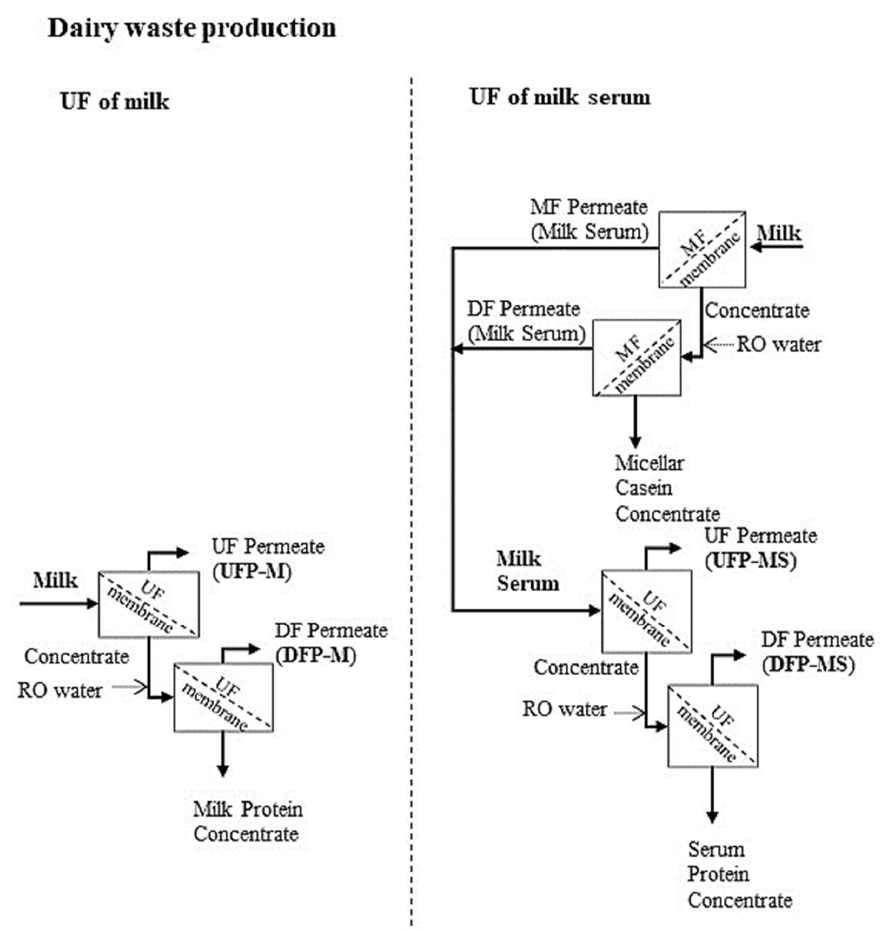
Figure 2. Production of dairy wastes (ultrafiltration permeates = fermentation substrates): UFP ‐ M = milk ultrafiltration permeate; DFP ‐ M = milk diafiltration permeate; UFP ‐ MS = milk serum ultrafiltration permeate; DFP ‐ MS = milk serum diafiltration permeate; UF = ultrafiltration; DF = diafiltration; MF = microfiltration; RO = reverse osmosis.